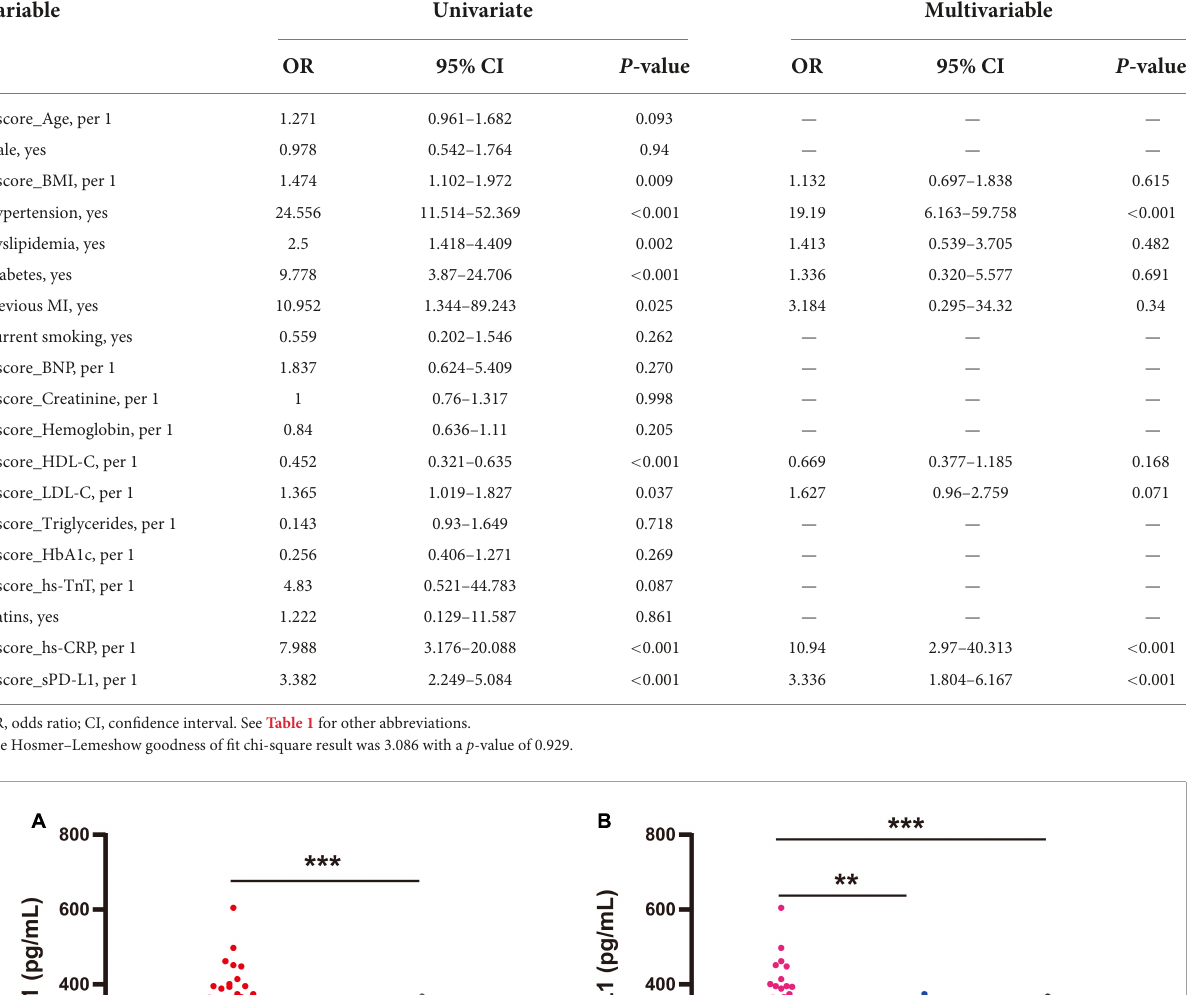
TABLE 2 Logistic regression analyses using Z score for acute coronary syndrome.